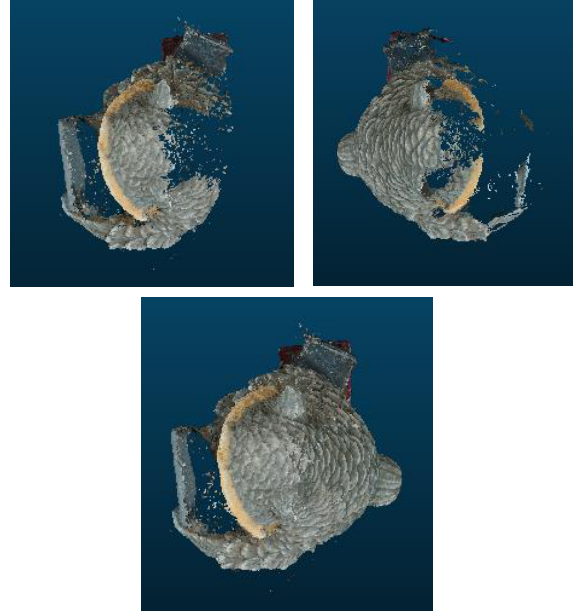
Figure 15: Point cloud before and after transformation.